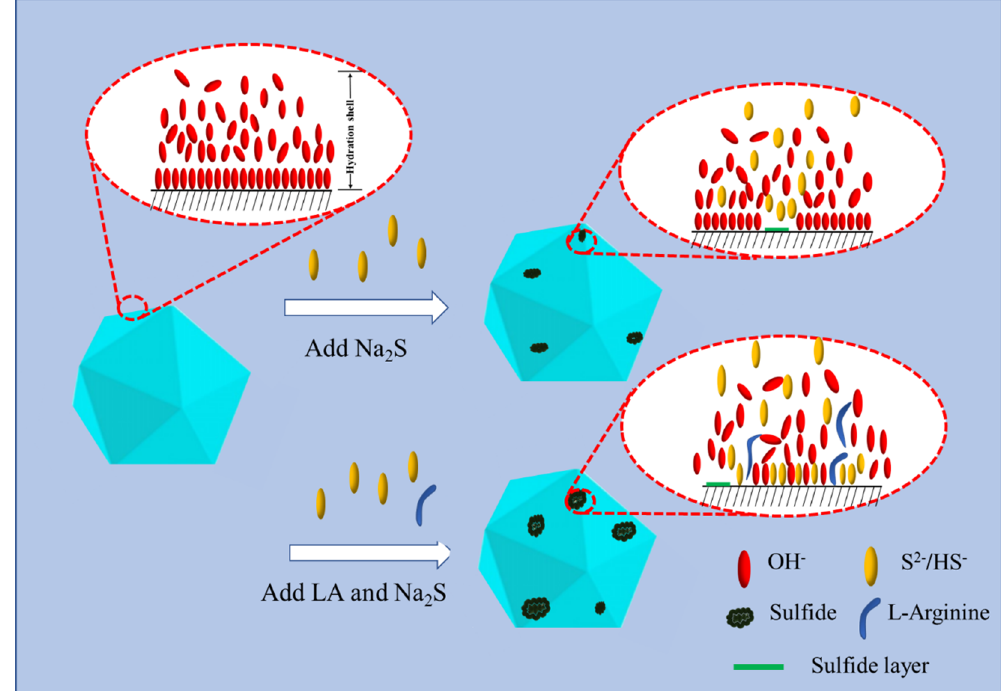
Figure 13. Proposed model of LA to promote malachite sulfidization flotation.